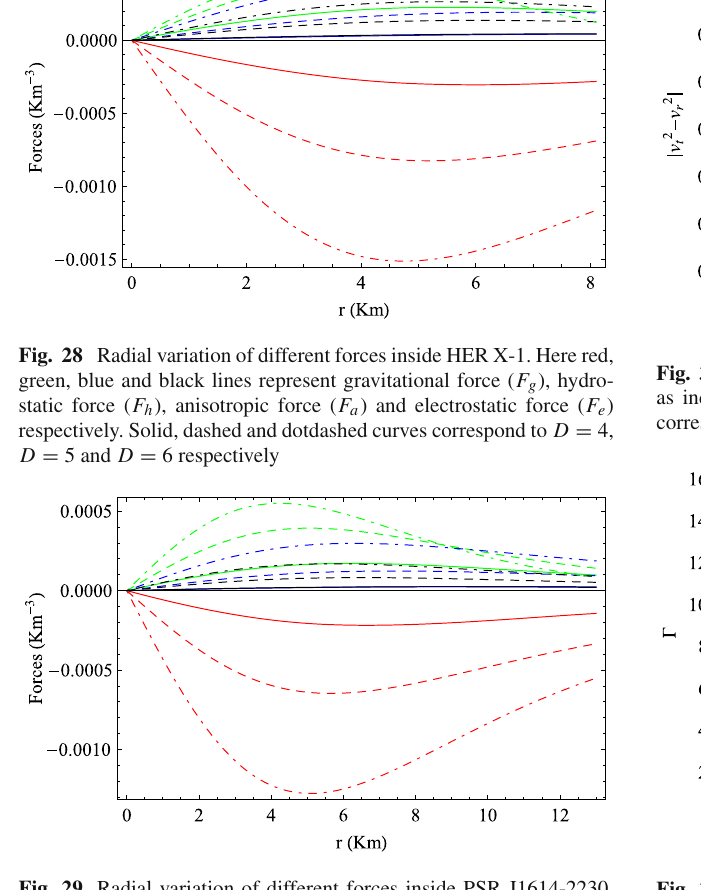
Fig. 32 Radial variation of adiabatic index ( Γ ) inside different com- pact objects as indicated in the figure. Here solid, dashed and dotdashed curves correspond to D = 4, D = 5 and D = 6 respectively. The black horizontal line represents the value 4